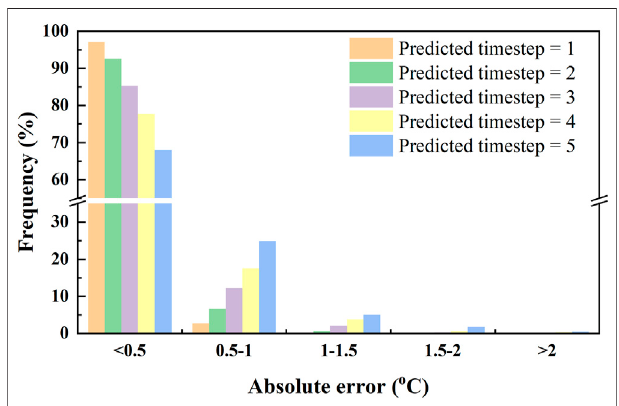
FIGURE 9 | Distribution of the absolute errors on test data.